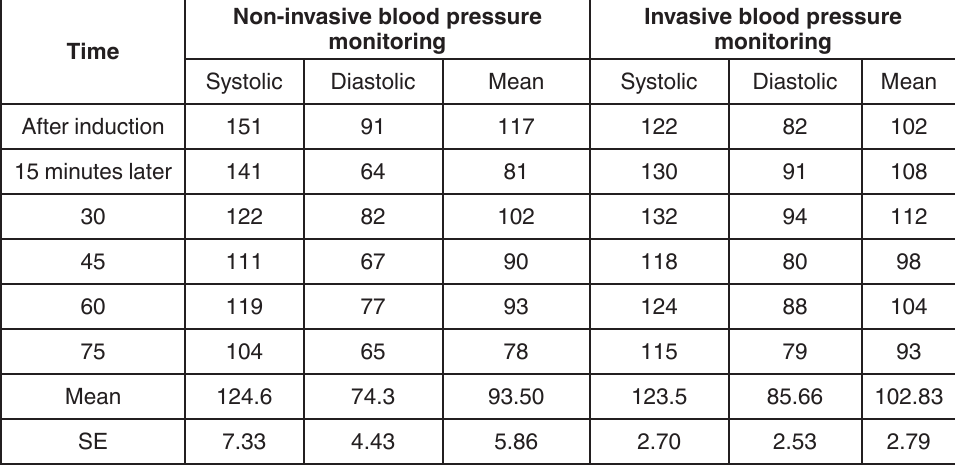
invasive blood pressure